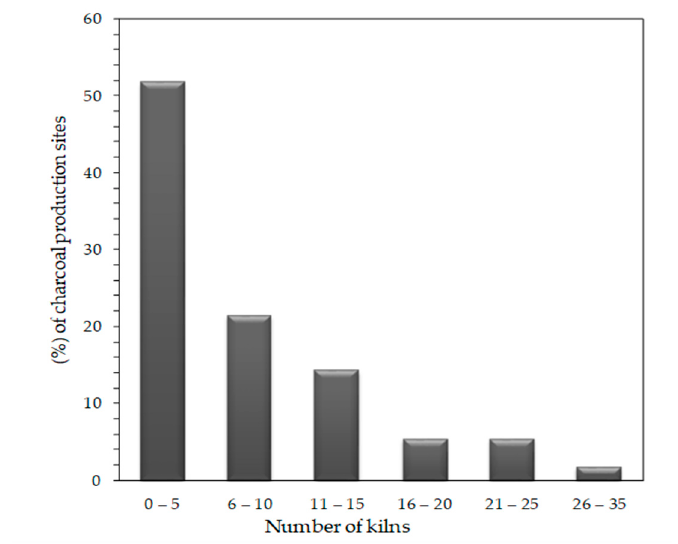
Figure 3. Percentage of charcoal production sites by the number of kilns.